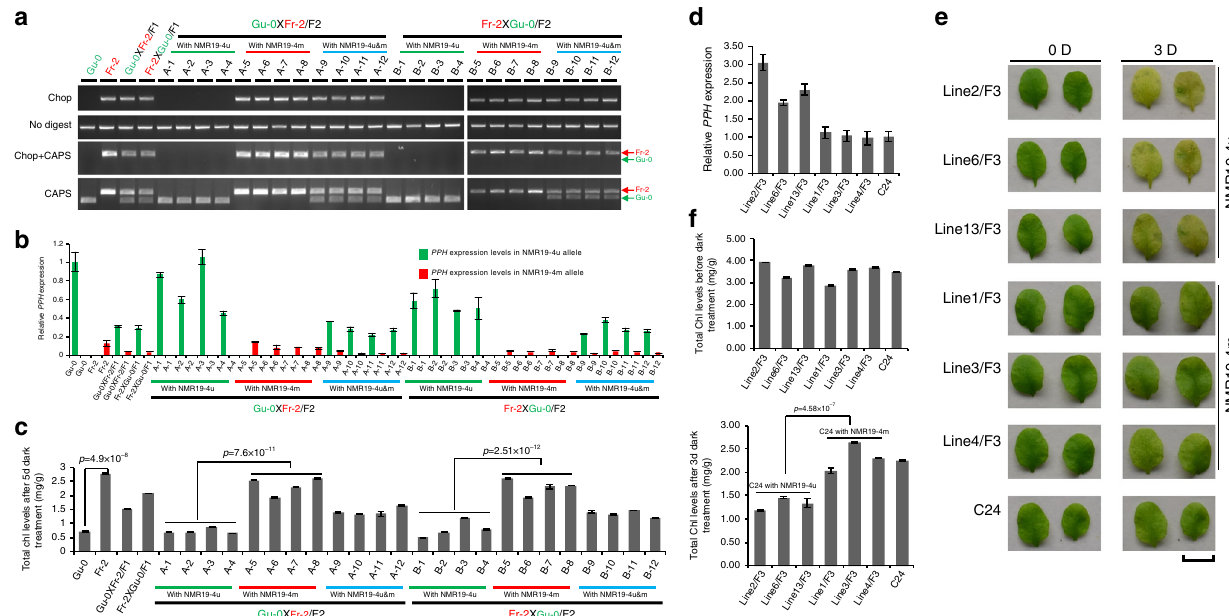
Fig. 6 NMR19-4m controls leaf senescence. a Examination of methylation status of NMR19-4 based on Chop-PCR in F1 hybrids and F2 recombinant lines. The arrows at the right side of gel picture indicate the allele that corresponds to the band in the gel. The numbers of A1 to A12 and B1 to B12 in a – c indicate different individual plants and each of them was used for three different assays including Chop-PCR, allele-speci fi c qPCR and darkness-induced leaf senescence. b Examination of expression levels of PPH in NMR19-4m and NMR19-4u alleles by allele-speci fi c qPCR. Error bars are de fi ned as s.e.m ( n = 3). c Quanti fi cation of chlorophyll content after 5 days of dark treatment in F1 hybrids and F2 recombinant lines. p -value was calculated by a two-tailed t -test, the same below. Error bars are de fi ned as s.e.m ( n = 3). d NMR19-4m represses the expression of PPH compared with NMR19-4u in C24 WT background. The different lines correspond to those in Fig. 4c and Supplementary Fig. 9, the same below. We con fi rmed (Fig. 4; Supplementary Fig. 9) that lines 2, 6, and 13 had unmethylated NMR19-4, and lines 1, 3, and 4 had methylated NMR19-4 in C24 WT background. Error bars are de fi ned as s.e.m. ( n = 3). e NMR19-4m delays leaf senescence under dark treatment. Scale bars, 1 cm. f Quanti fi cation of the phenotype from e . Total chlorophyll levels were determined before (upper) and after (bottom) 3 d dark treatment. Error bars are de fi ned as s.e.m. ( n =